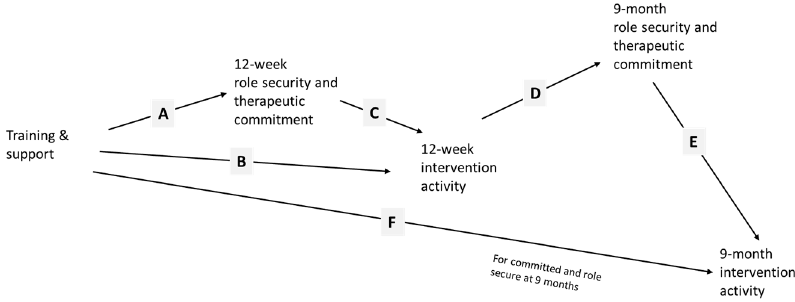
Figure 1. Hypothesized path model for training and support.